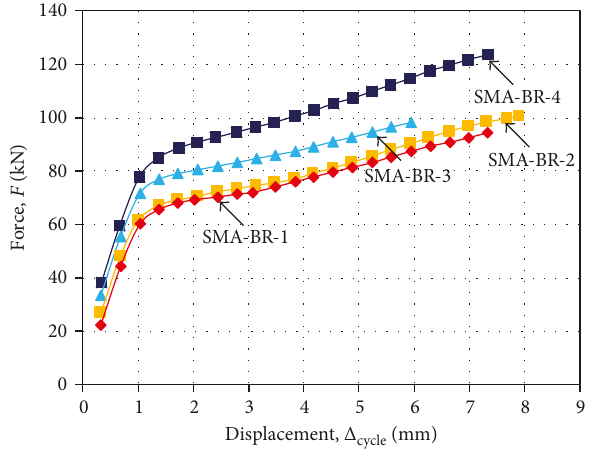
Figure 12: Comparison for loading forces along the measurement displacement loading cycles (SMA-BR model series).